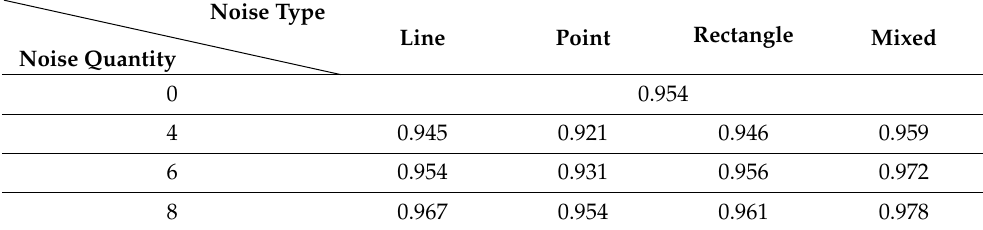
Table 8. Detection confidence on 4 types of noises (test in validation data).